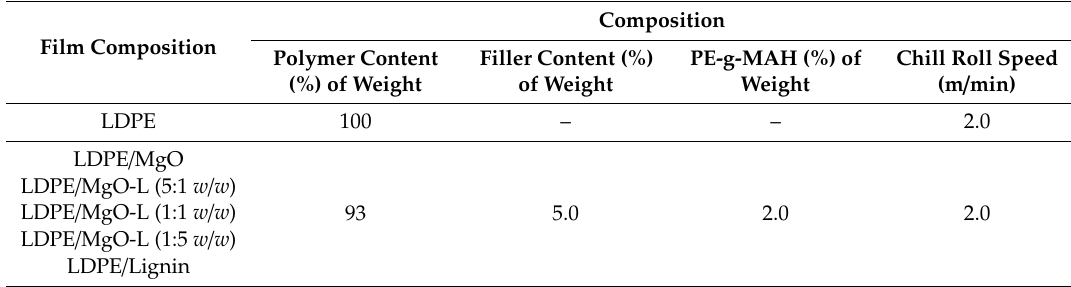
Table 1. The list of prepared compositions with content of MgO, lignin and MgO-lignin fillers in the LDPE matrix in extruded films. Composition Film Composition Polymer Content Filler Content (%) PE-g-MAH (%) of (%) of Weight of Weight